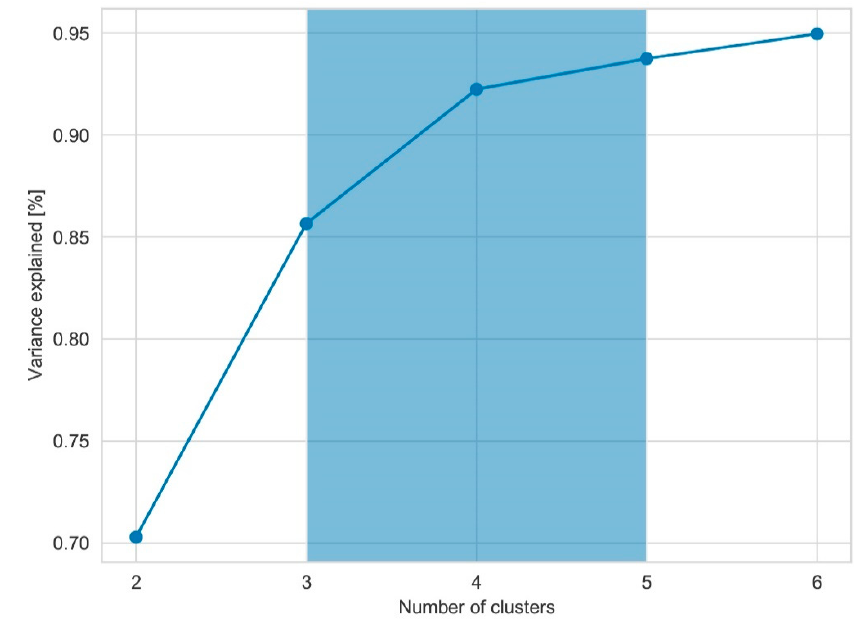
Figure 7. Evaluation of goodness of variance fit using elbow method.